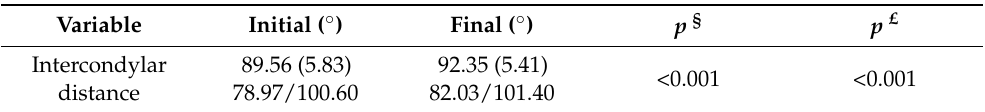
Table 3. Intercondylar distance before and after maxillary expansion. The values are presented in the following order: mean (standard deviation) minimum/maximum.